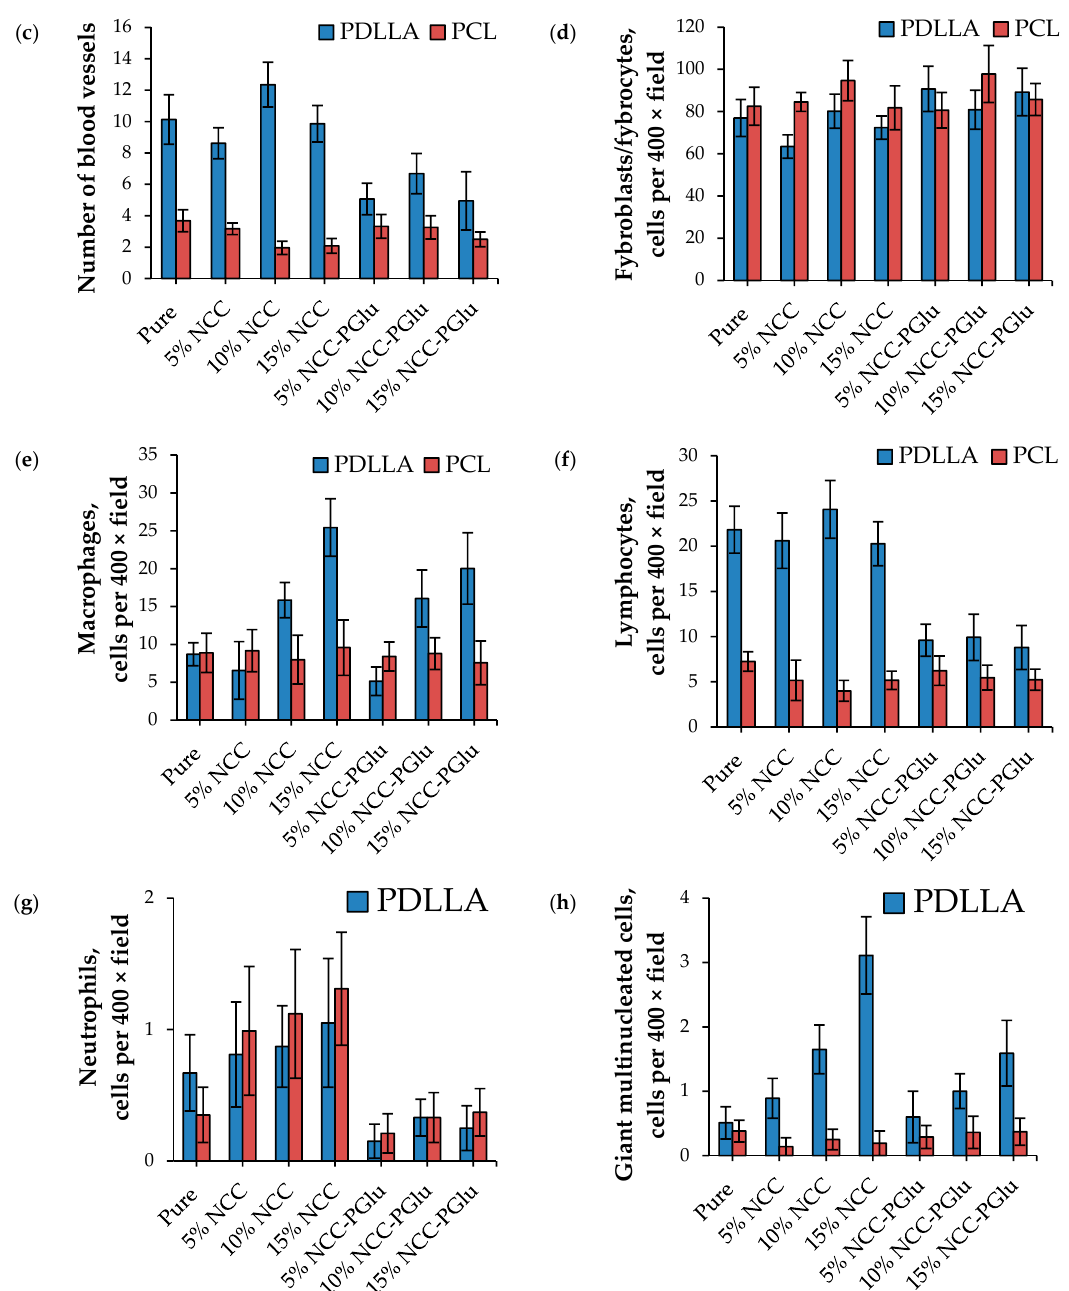
Figure 9. Results of histological analysis after subcutaneous rat implantation with pure aliphatic polyester-based film specimens and these filled with neat and modified NCC: ( a ) the thickness of fibrous capsule, ( b ) and ( c ) the average number of collagen layers and blood capillaries, ( d )–( h ) the average number of different cells per 400 × field, e.g. fibroblasts, macrophages, lymphocytes, neutrophiles, and giant multinucleated cells.